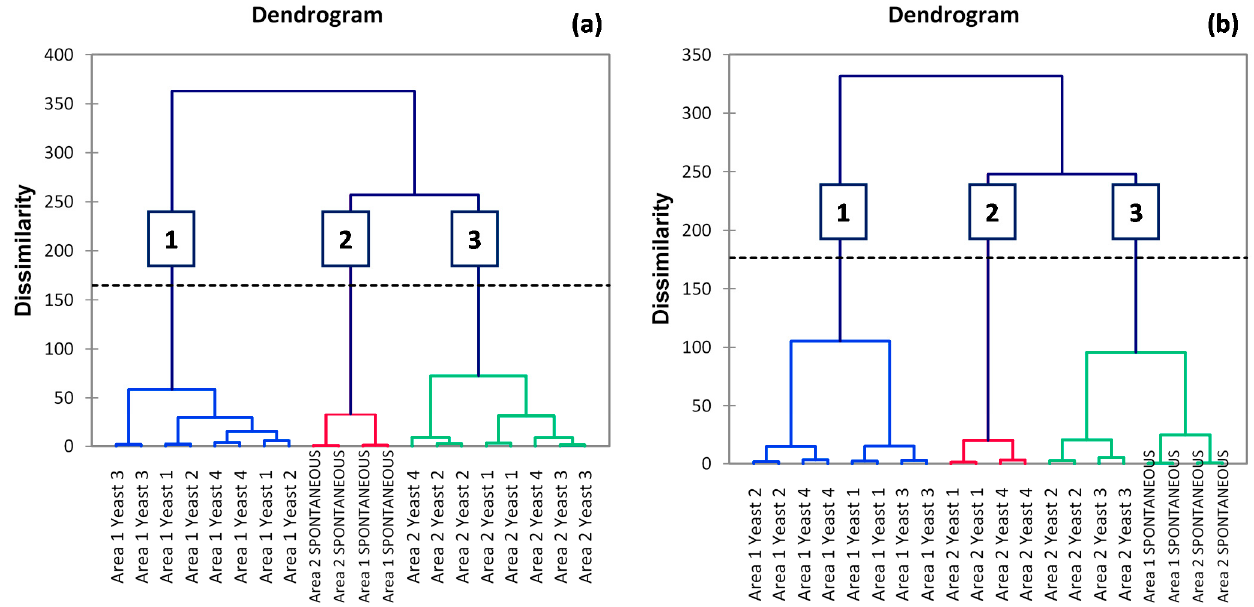
Figure 4. HCA of ( a ) Corvina and ( b ) Corvinone withered grapes wines sorting task